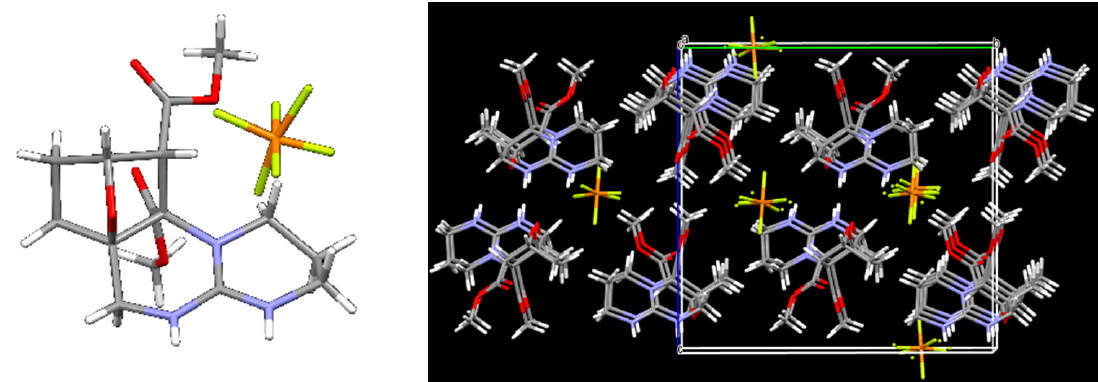
Figure 2. X-ray structure of the derivative 7d· HPF 6 .